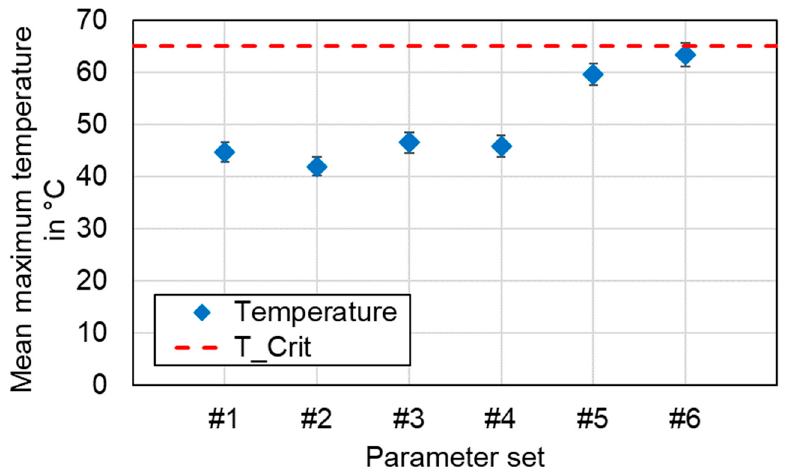
Figure 24. Mean temperatures occurring in the seam adjacent area during welding for parameter sets #1–#6 (see Table 5).